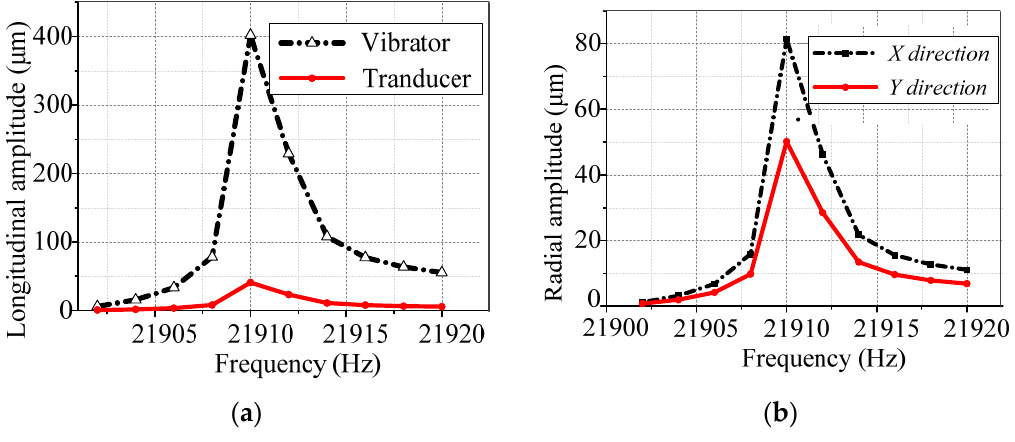
Figure 8. Harmonic response of the power-superimposing vibration system. ( a ) Longitudinal amplitude vs. frequency of the vibrator and transducers. ( b ) Radial amplitude vs. frequency in X and Y directions.